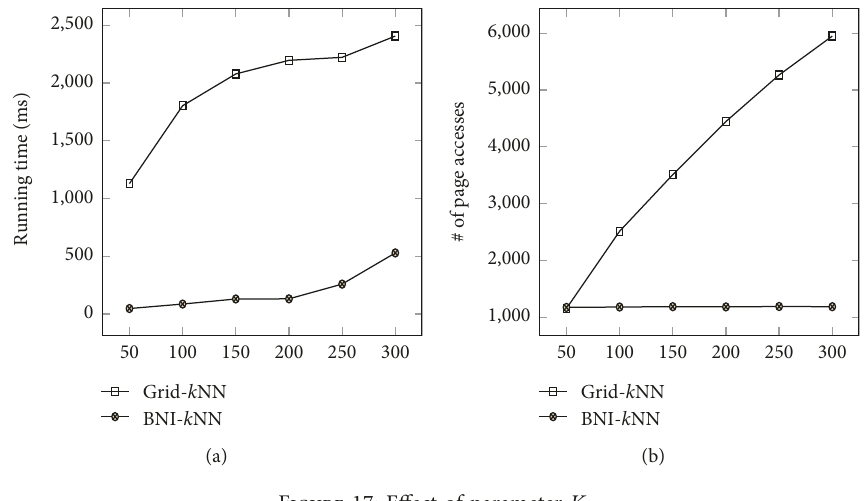
Figure 17: Effect of parameter K